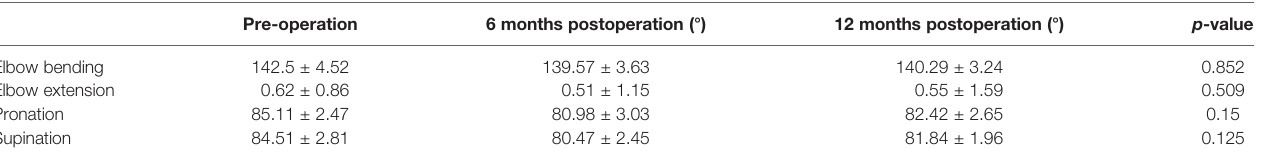
TABLE 5 | Elbow joint motor function assessment of modi fi ed